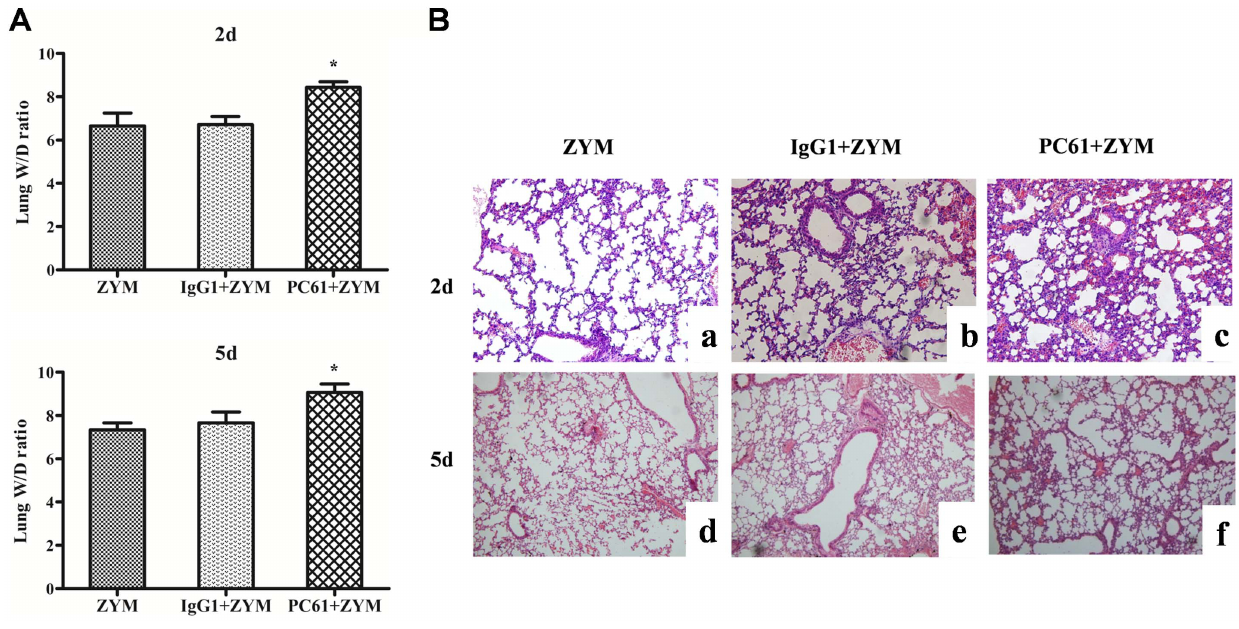
Figure 6. Lung W/D ratio and histology of ZIGI mice with depleted levels of Treg cells. Lung W/D ratio (A, n=6 for each group). The lungs of ZIGI mice, which had depleted levels of Treg cells, were collected and stained with hematoxylin-eosin (B, original magnification: 10 6 ). The values show the means 6 SEM. * P , 0.05compared with the ZYM and the IgG1 + ZYM groups.